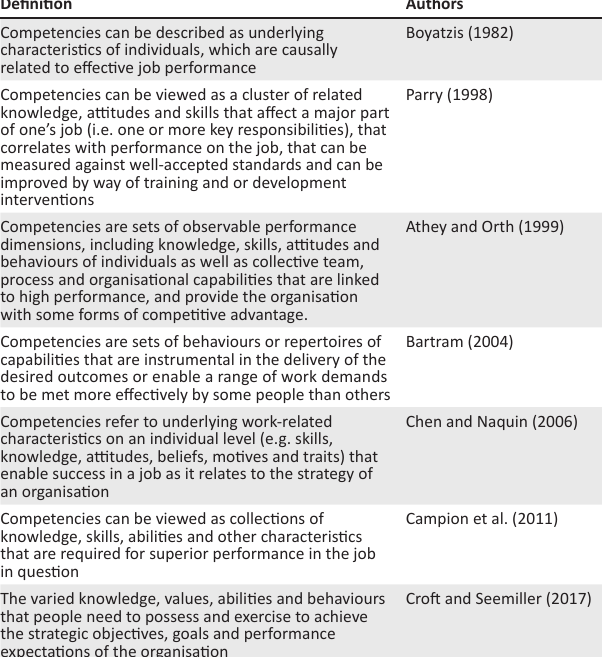
TABLE 1: Influenctial competency